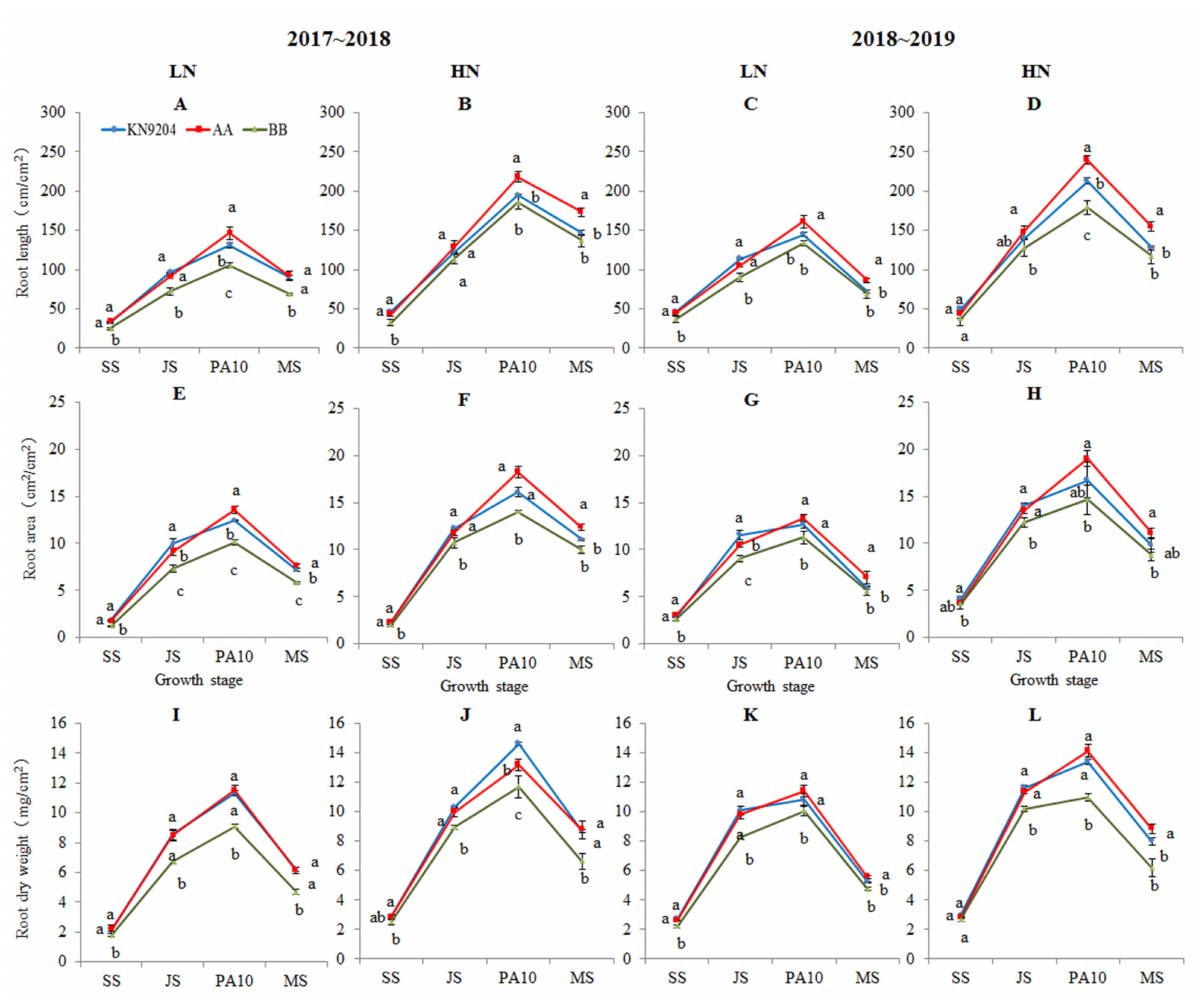
Figure 1. Root length (RL) ( A – D ), root surface area (RA) ( E – H ) and root dry weight (RDW) ( I – L ) of KN9204 and the QMrl - 7B near isogenic lines (NILs) at different stages. Note: 2017~2018 and 2018~2019 indicate growing seasons; LN and HN indicate low nitrogen and high nitrogen environments, respectively; AA indicates QMrl - 7B NILs with the superior alleles; BB indicates QMrl-7B NILs with the inferior alleles. SS, JS, PA10 and MS indicate seedling stage, jointing stage, 10 days post anthesis and maturity, respectively. Different lowercases indicate significant differences ( p < 0.05) among the